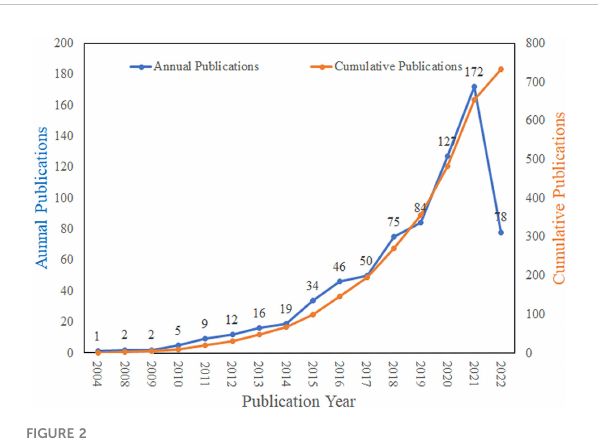
FIGURE 2 Trends of publications on autophagy in OA from 2004 to